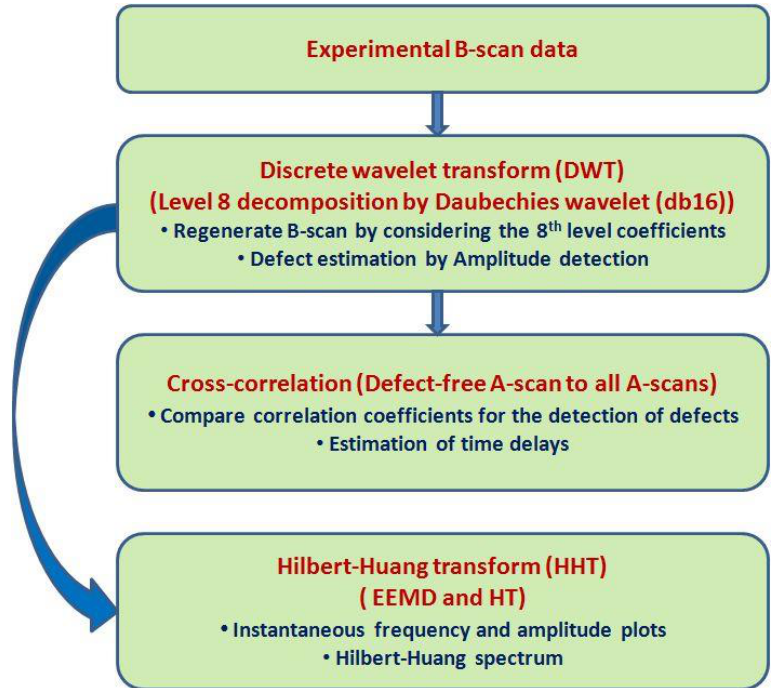
Figure 6. The proposed hybrid signal processing scheme.